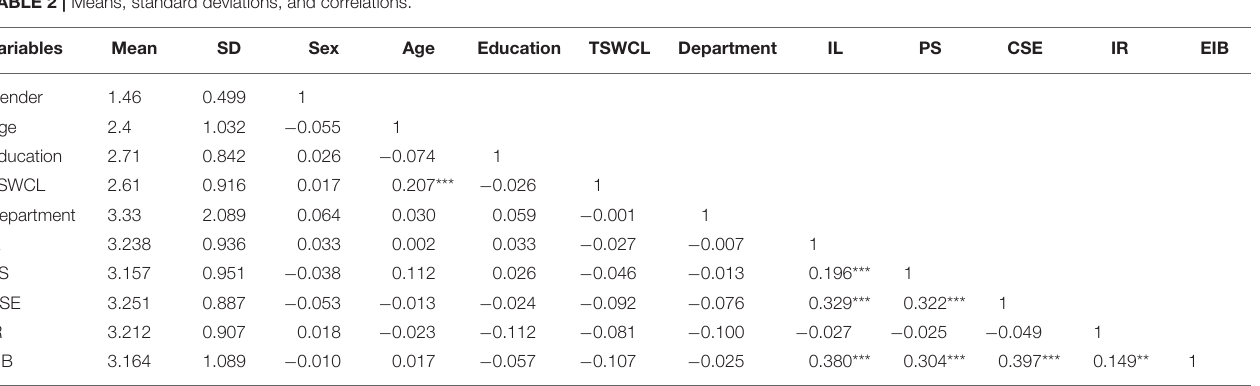
TABLE 2 | Means, standard deviations, and